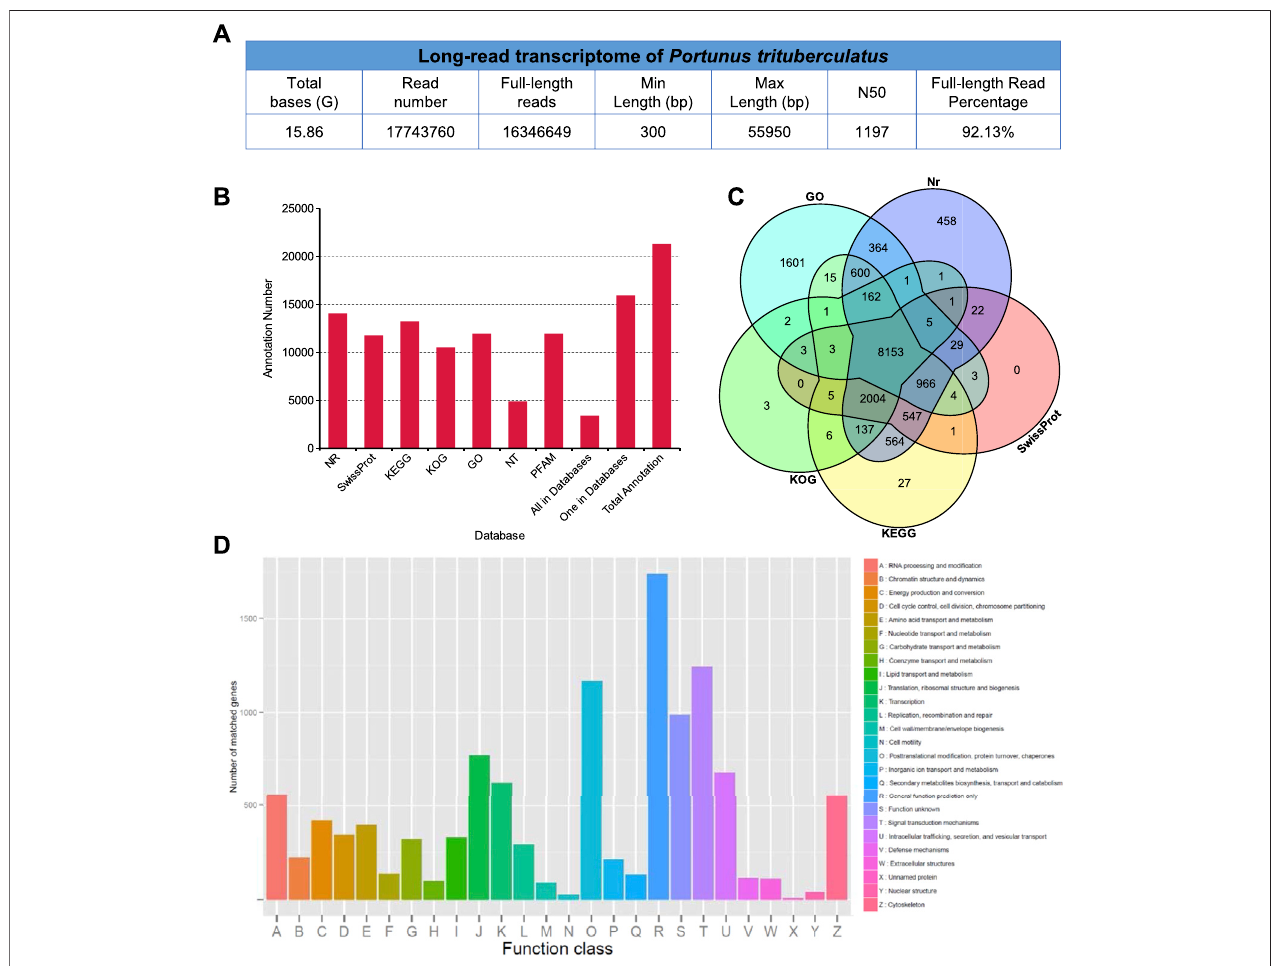
FIGURE 1 | In silico transcriptome analysis in Portunus trituberculatus . (A) Long-read transcriptome of P. trituberculatus . (B) The functional annotation of non- redundant sequences in seven databases. (C) Comparison of transcripts present in different datasets, including GO, Nr, KOG, SwissProt, KO and KOG. (D) Functional classi fi cation of assembled